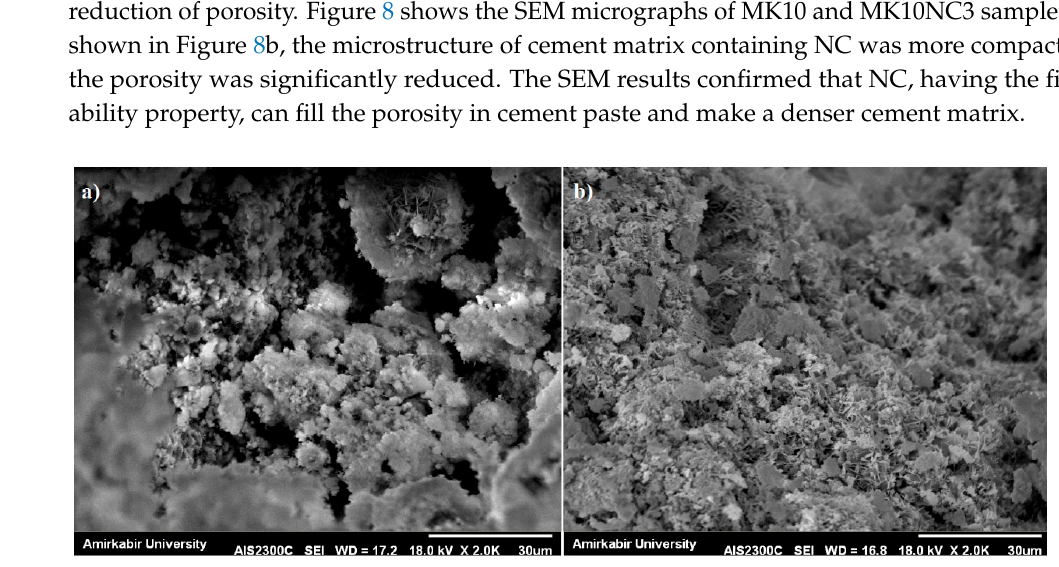
Figure 8. SEM images of: ( a ) MK10 sample; and ( b ) MK10NC3 sample.